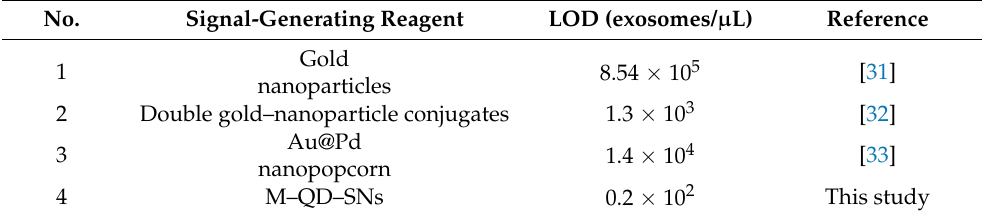
Table 1. Comparison of nanoparticle types and limit of detection (LOD) in test strip studies of exosome detection.